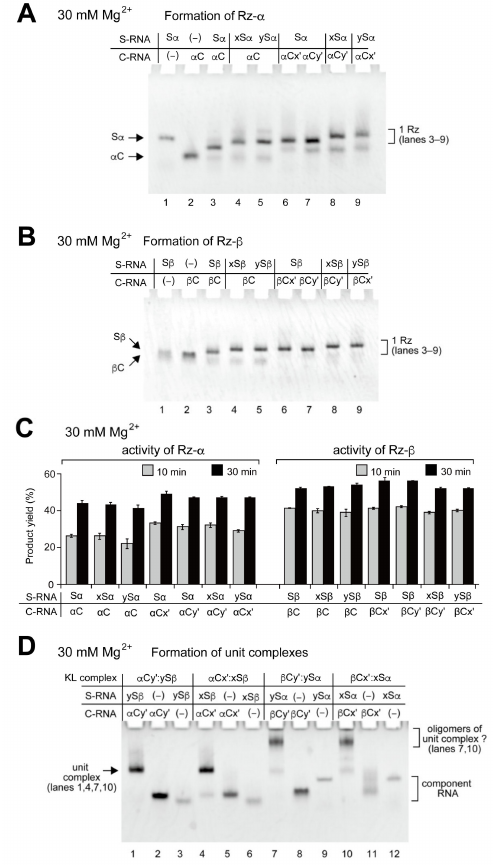
Figure 2. Formation of bimolecular ribozymes and unit complexes. ( A , B ) EMSA of Rz- α ( A ) and Rz- β ( B ) bimolecular ribozymes in the presence of 30 mM Mg 2+ . The concentration of each RNA component was 0.5 µ M. ( C ) Pre-tRNA cleavage reaction catalyzed by bimolecular ribozymes (Rz- α and Rz- β ) in the presence of 30 mM Mg 2+ . Reactions were performed for 10 min and 30 min. The concentration of each RNA component was 0.5 µ M. ( D ) EMSA of unit complexes in the presence of 30 mM Mg 2+ . The concentration of each RNA component was 0.5 µ